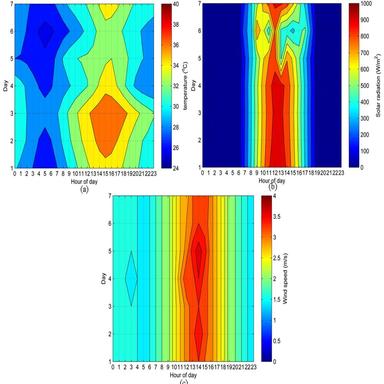
Meteorological parameters from 1st July to 7th July in Changsha: (a) the ambient temperature; (b) the solar radiation; (c) the wind speed.